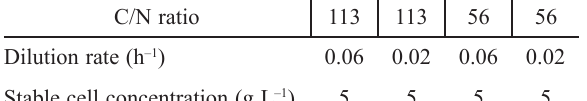
Table 1 – Cell productivity, lipid productivity, and glucose consumption for continuous cultivation of L. star- keyi C/N